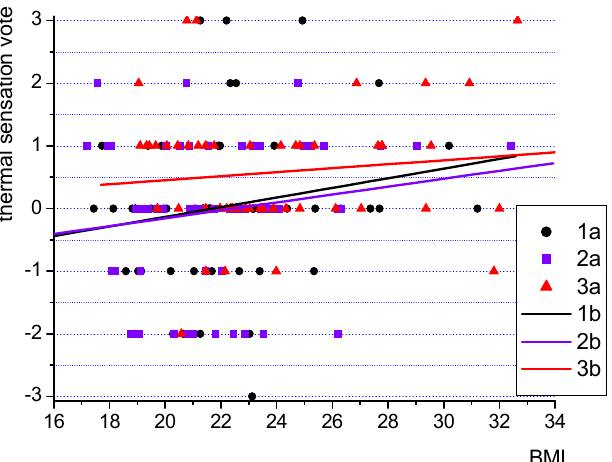
Figure 17. Relationship between thermal sensation votes and body mass index (BMI) for 3 different groups of people; 1a: survey on 65 people, 2a: survey on 60 people, 3a: survey on 57 people; 1b, 2b, 3b: linear fits of 1a, 2a and 3a, respectively.